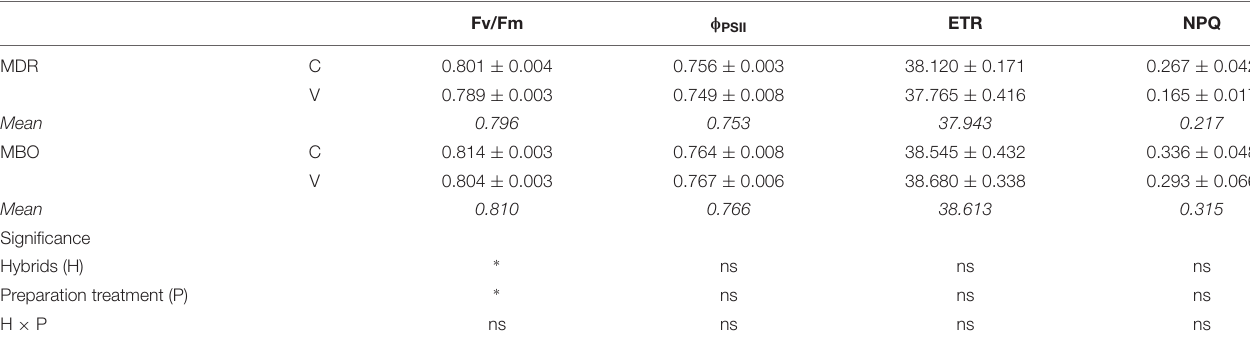
TABLE 1 | Maximal PSII photochemical efficiency (Fv/Fm), quantum yield of PSII electron transport ( φ PSII ), linear electron transport rate (ETR) and non-photochemical quenching (NPQ) in plants of Ranunculus asiaticus L. hybrids MBO and MDR, obtained by two preparation procedures of tuberous roots, only rehydration (Control, C) and rehydration plus vernalization (V).